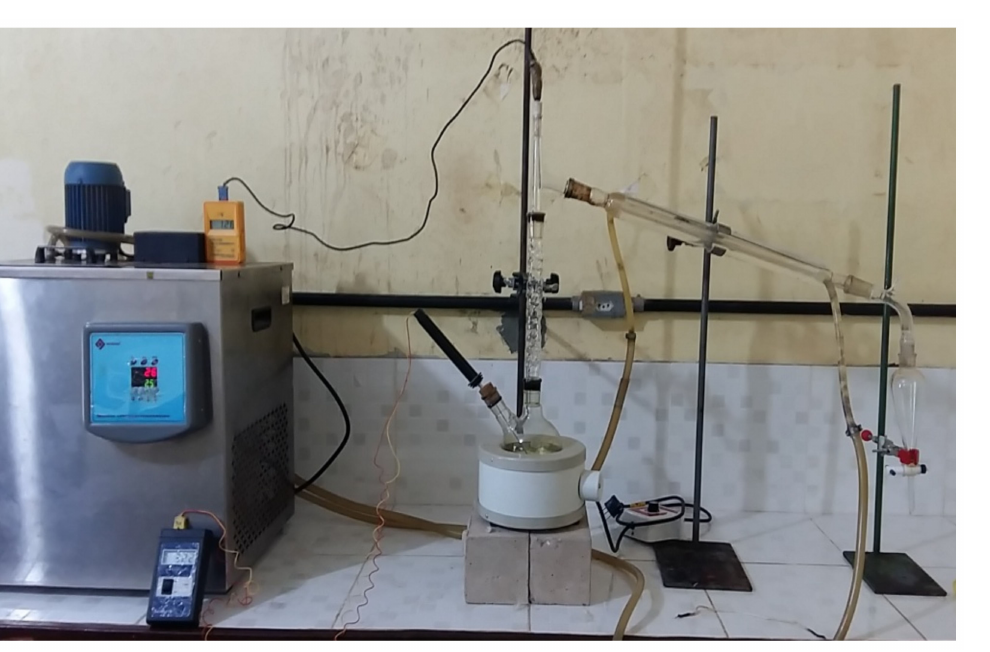
Figure 6. View of distillation column